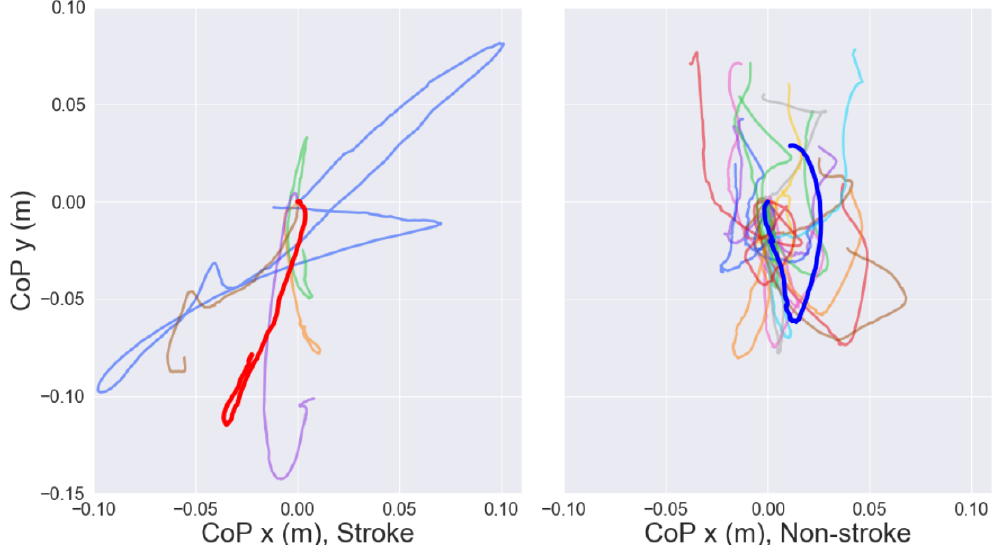
Figure 5. Centre of pressure trajectories for stroke and non-stroke participants, with the start position of each line normalised to (0,0). Each colour represents a participant. Single examples highlighted solely for clarity of